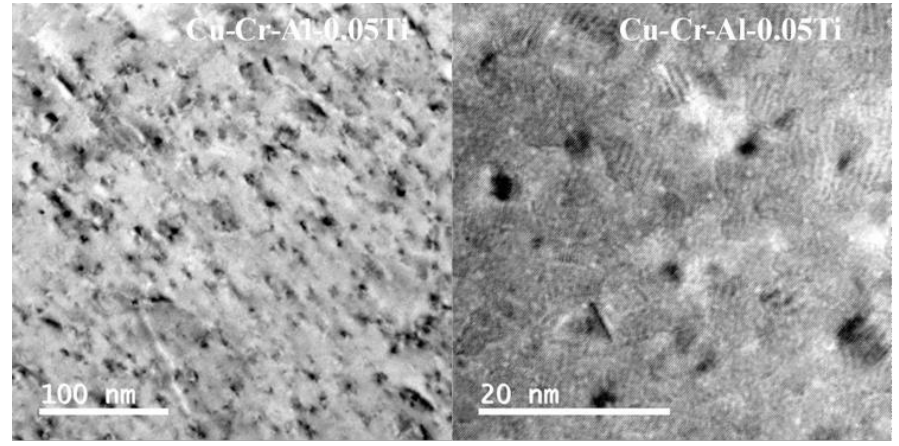
Figure 14. Observation and identification of precipitation of Cu-Cr alloys by TEM. Table 1. List of chemical compositions of Cu-Cr alloys by using spectrometer. Wt.% Cr Al Ti Cu Cu-0.25Cr 0.2677 0.0011